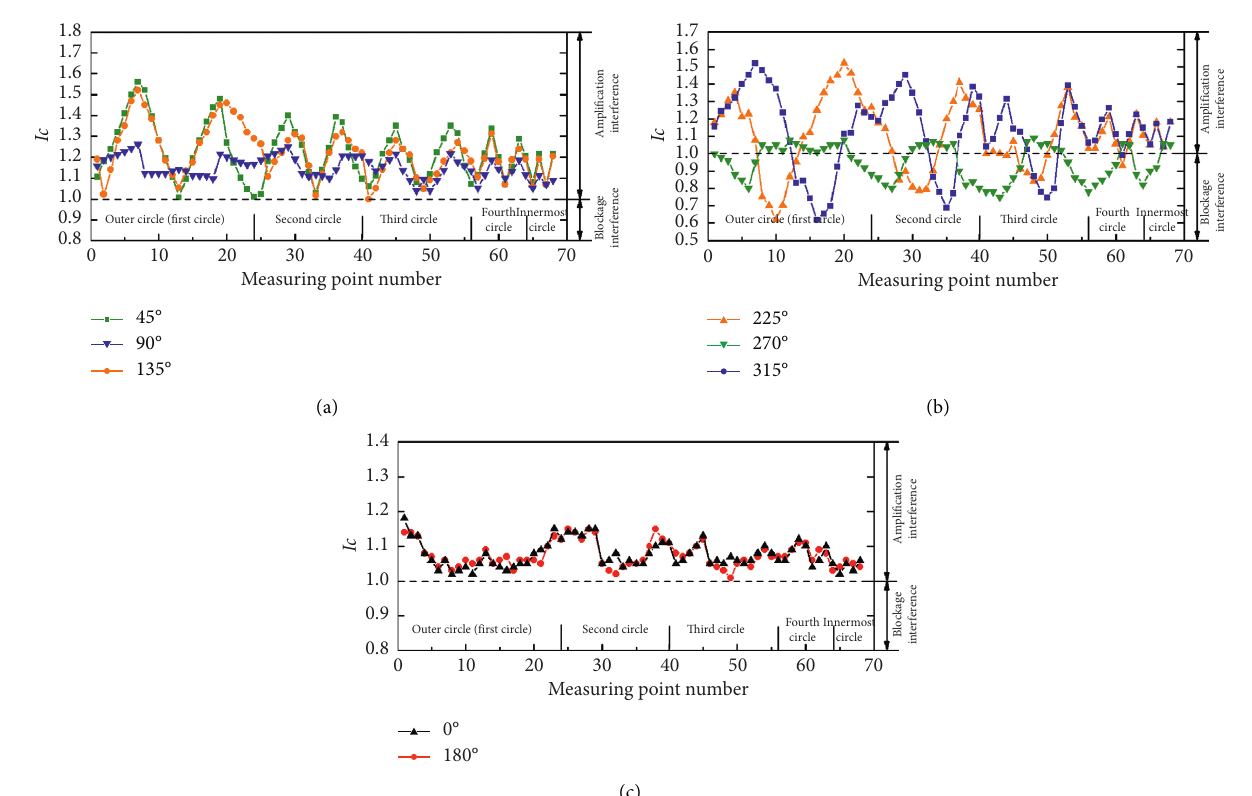
Figure 16: Interference coefficients for the gymnasium surface for different wind direction angles. (a) 45 ° , 90 ° , and 135 ° . (b) 225 ° , 270 ° , and 315 ° . (c) 0 ° and 180 °